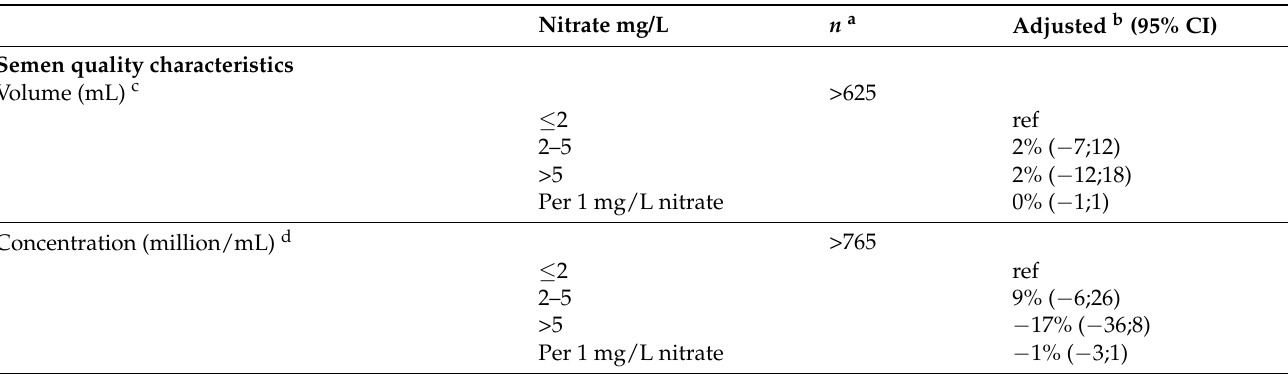
Table 4. Relative difference in percent in semen quality characteristics, testes volume and reproductive hormone levels in relation to nitrate concentration in the sons’ drinking water three months prior to the clinical